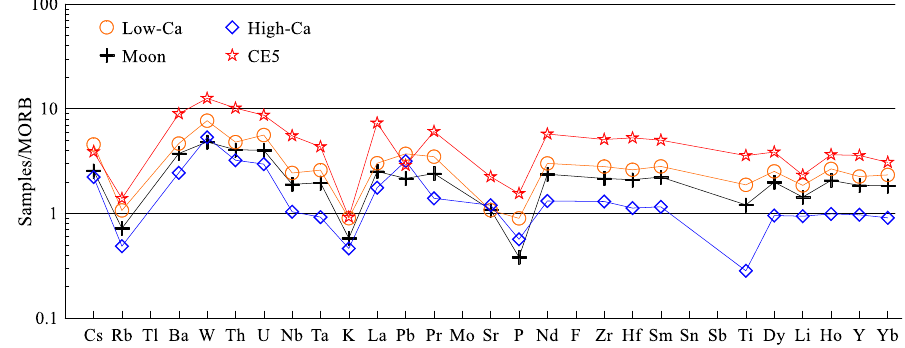
Figure 5. Spider diagrams of moon samples normalized to the MORB. Abundances of the MORB are from White and Klein [14].